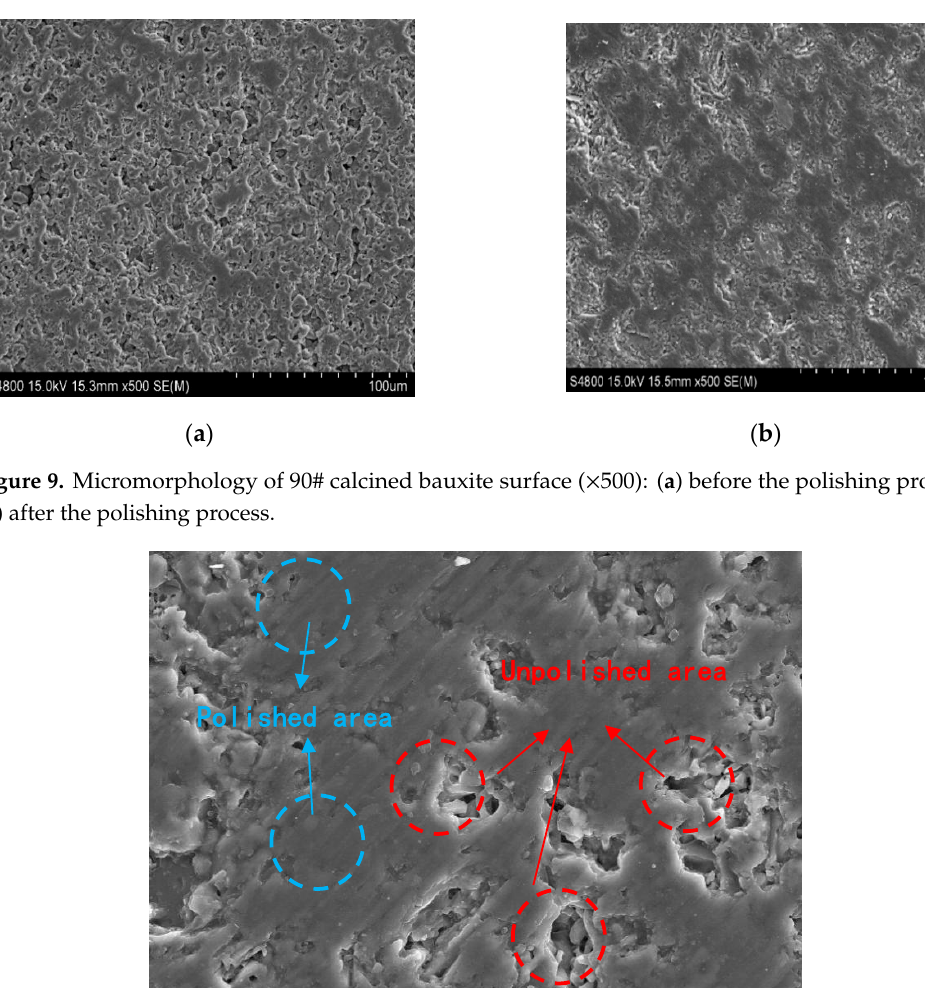
Coatings 2019 , 9 , x FOR PEER REVIEW